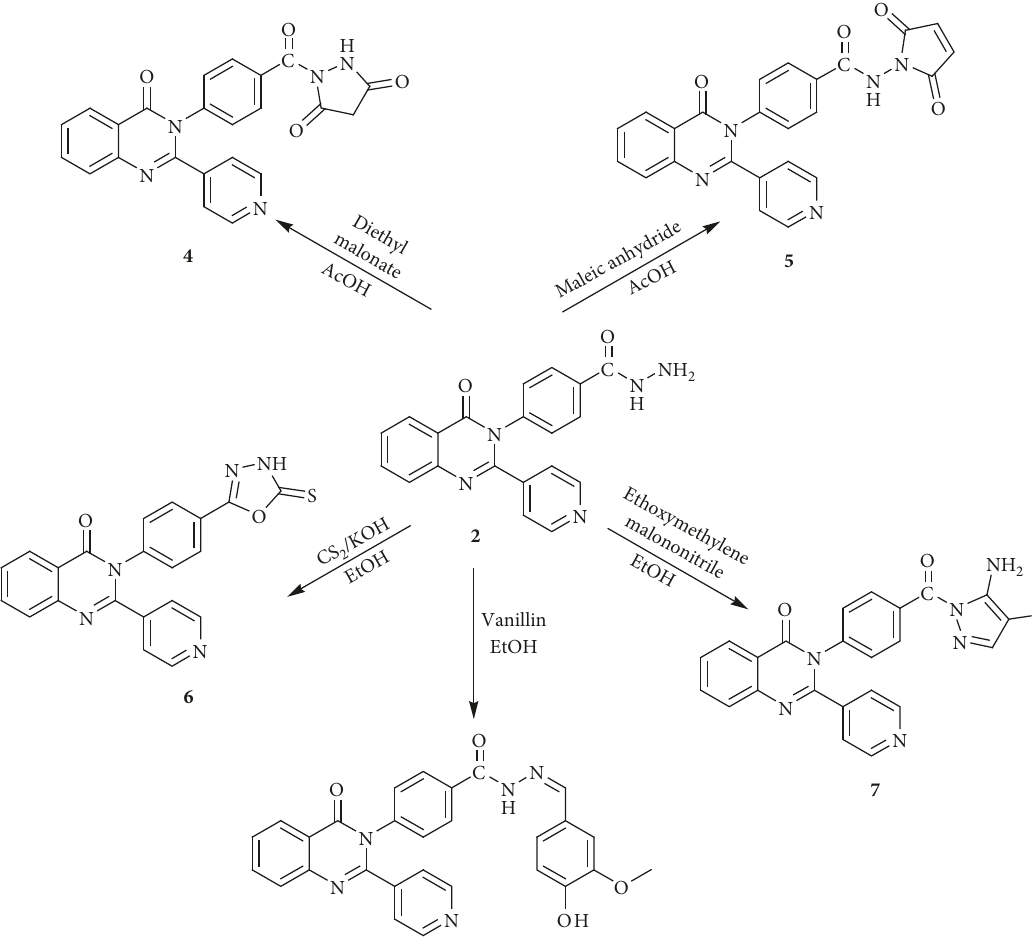
Scheme 2: Synthesis of compounds 4 – 8